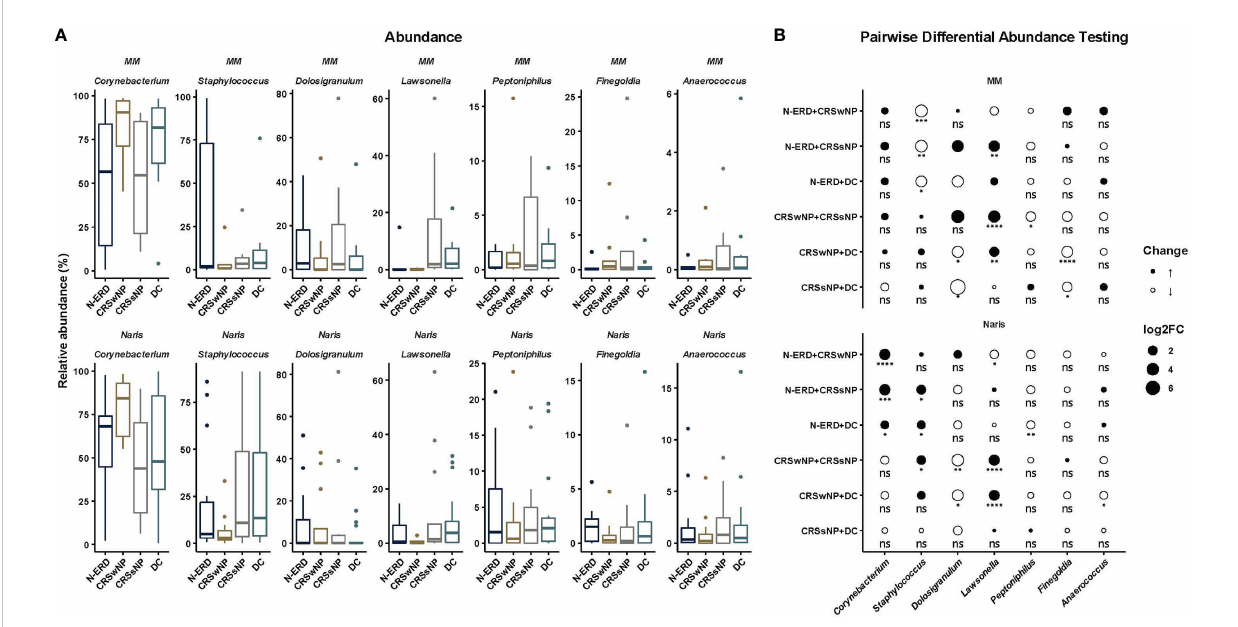
FIGURE 4 Microbiome taxonomic pro fi les by disease and origin in patients suffering from chronic rhinosinusitis with (CRSwNP) or without nasal polyposis (CRSsNP), or non-steroidal anti-in fl ammatory drug-exacerbated respiratory disease (N-ERD) as compared to disease controls (DC). (A) Relative abundance is displayed in percentage (y-axis) in patients with CRSsNP (grey; n AN =13, n MM = 8), CRSwNP (brown; n AN =13, n MM = 8) or N-ERD (dark blue; n AN =14, n MM = 7) as compared to disease controls (DC, light blue; n AN =19, n MM = 11). (B) Pairwise differential abundance testing was performed using DESeq2 with alpha=0.05. Log2 fold change (log2FC) is shown by size and color of circles [black = enlargement, white = reduction; circle size small = increase of abundance doubled, middle size = increase of abundance quadrupled, big size = increase of abundance sixfold; stars represent statistically signi fi cant differences between groups (*P ≤ 0.05, **P ≤ 0.01, ***P ≤ 0.001, ****P ≤ 0.0001, ns, non-signi fi